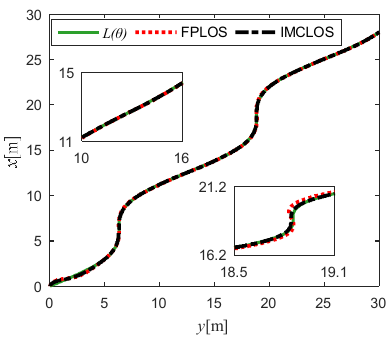
~ ,ˆ, ~ ,ˆ, Figure 5.  from IMCLOS and FPLOS. Figure 5.  from IMCLOS and FPLOS. ~ ,ˆ, Figure 5. ˆ β from IMCLOS and FPLOS. Figure 5.  from IMCLOS and FPLOS.